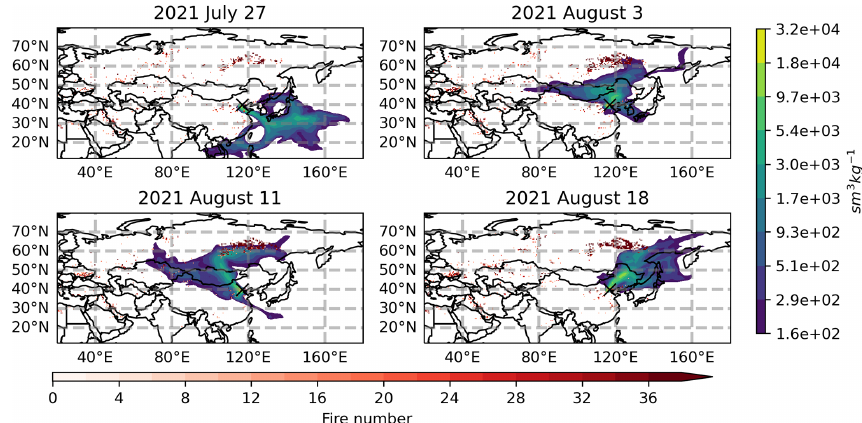
Figure 12. Spatial distributions of the air mass response sensitivity in 10d backward simulations at Xianghe using the FLEXPART v10.4 model on 27 July, 4 August, 11 August, and 18 August 2021. The air is treated as a trace gas, and 20000 particles are released at 0–2km above Xianghe in the temporal window of ± 1h around the local noon. Xianghe site is remarked as the black cross. The fire counts are observed by the VIIRS/Suomi NPP satellite, and all individual fires within 1 to 10d before each air mass release day are summed up and binned into 0.5 ◦ × 0.5 ◦ global